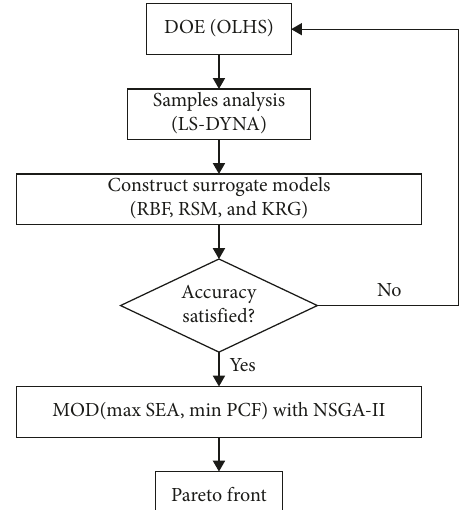
Figure 7: Flowchart of multiobjective optimization based on the surrogate model.